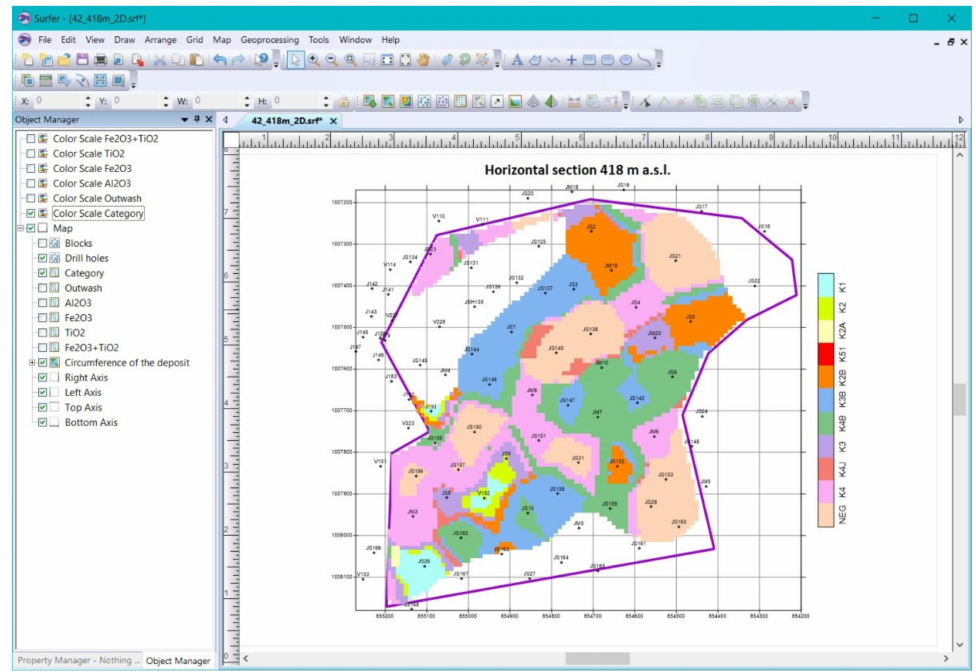
Figure 19. Visualization of a horizontal section 418 m a.s.l. in the Surfer environment.